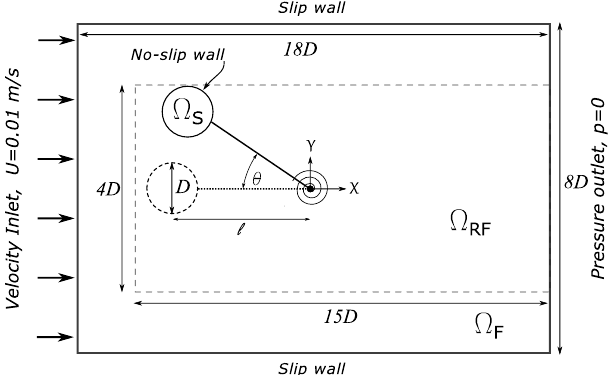
Figure 1. Schematic diagram of a typical computational domain and boundaries. Here, the pivot point is located at the downstream of the cylinder. The solid sub-domain is Ω S , the fluid sub-domain is Ω F , and Ω RF is the refined part of the fluid sub-domain. The arm length l is the distance between the center of the bluff body and the pivot